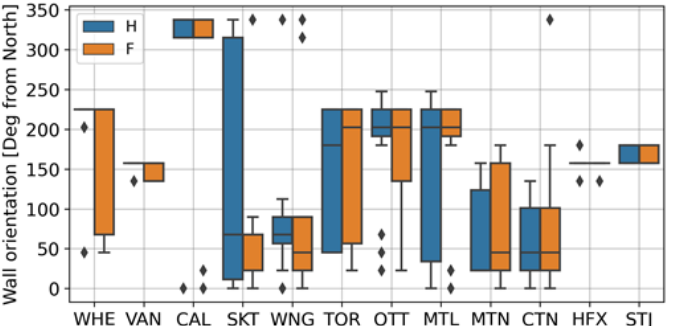
Figure 6. Boxplots of wall orientation for historical (H) and future periods (F). Each box shows the variation of wall orientations obtained with the test year for the 15 climate realizations in each time period.